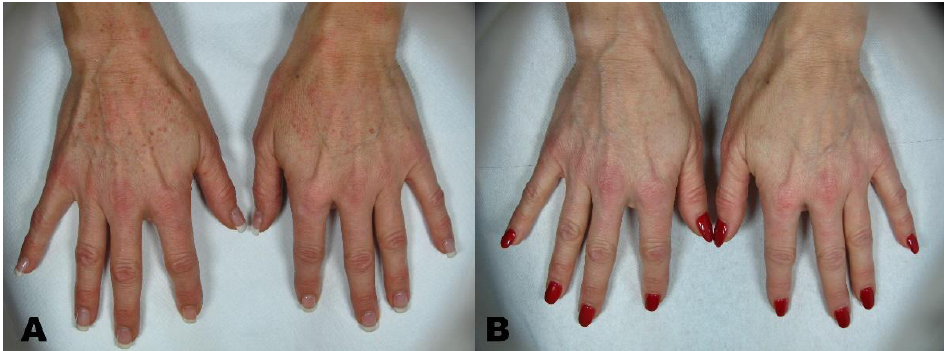
Figure 3. ( A ) Multiple lentigo before treatment; ( B ) region three months after the last session.